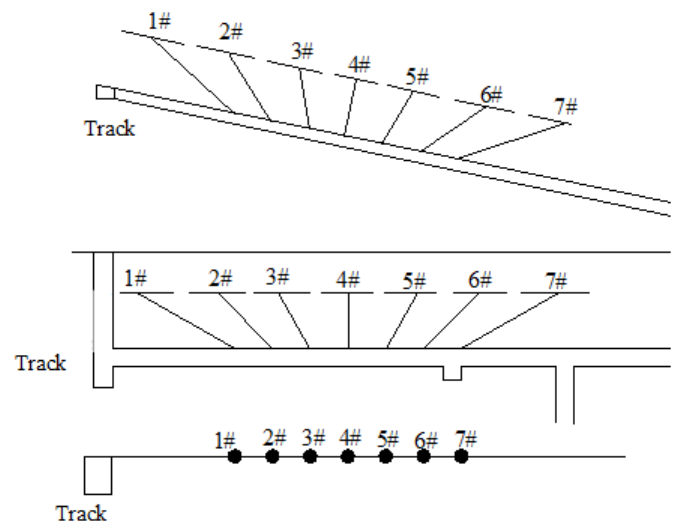
Figure 7. Arrangement plan of the blast. Table 3. Bore